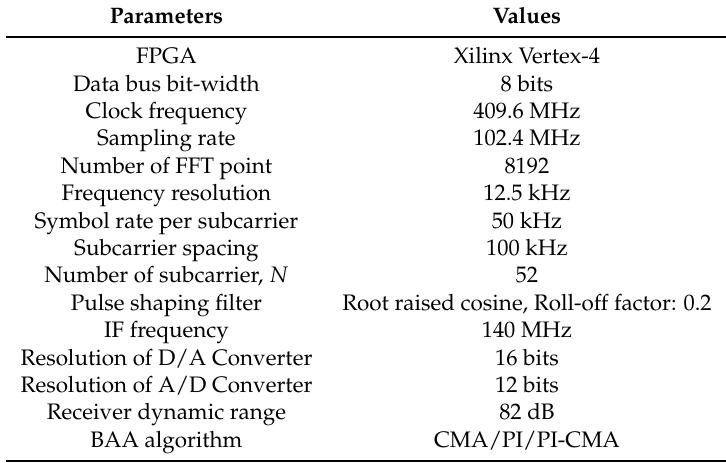
Figure 3. External of the prototype. RF: radio frequency; FEC: forward error correction. Table 2. Prototype specifications. FPGA: field programmable gate array; FFT: fast Fourier transform; IF: intermediate frequency; D/A: digital-to-analog; A/D: analog-to-digital; BAA: blind adaptive array; CMA: constant modulus algorithm; PI: power